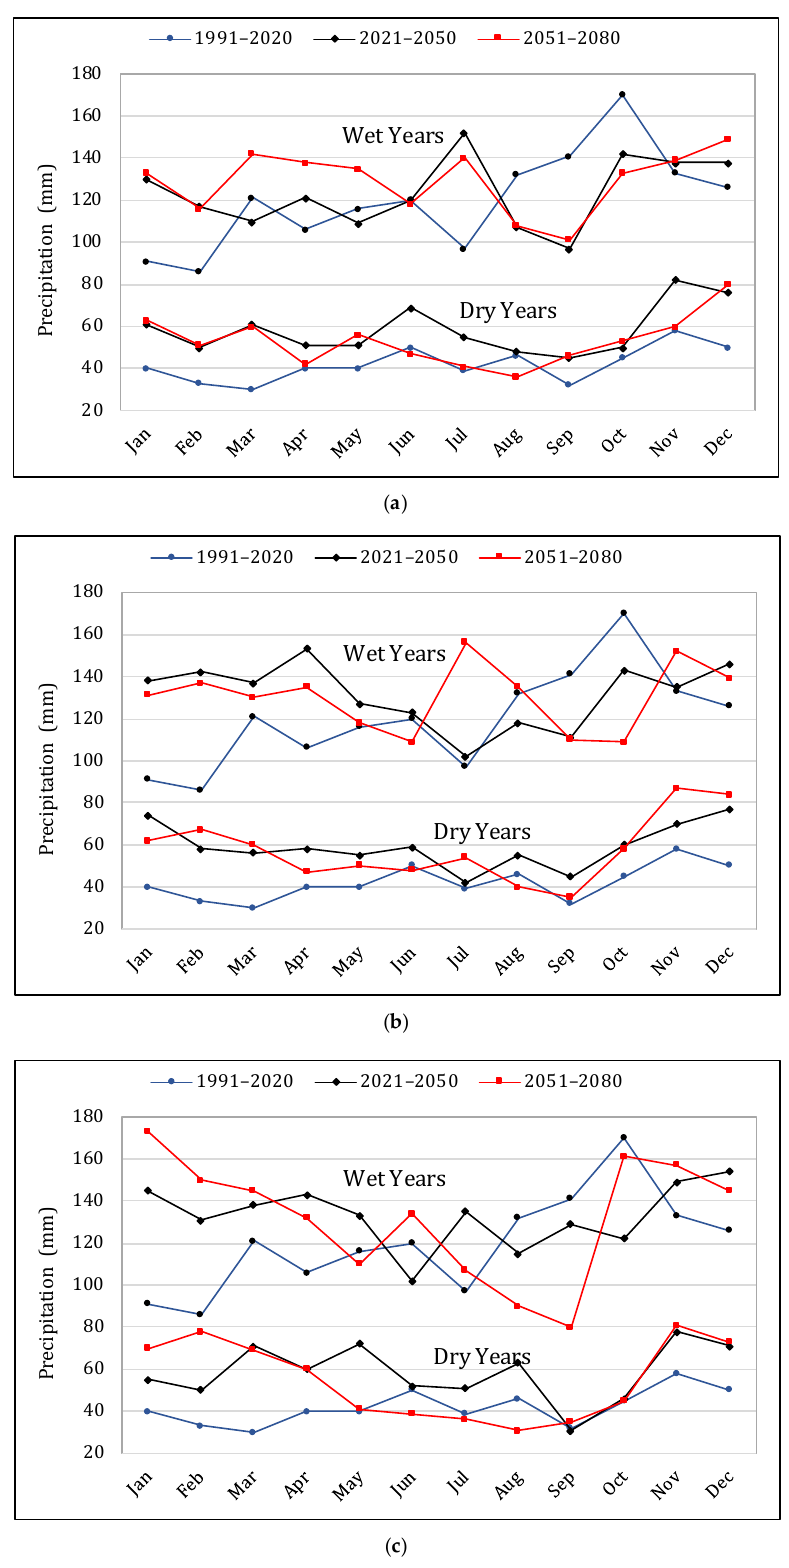
Figure 9. Expected monthly precipitations during wet (PoE = 20%) and dry years (PoE = 80%) under the RCP2.6 ( a ), RCP4.5 ( b ), and RCP8.5 ( c ) scenarios in the western zone (Summerside).